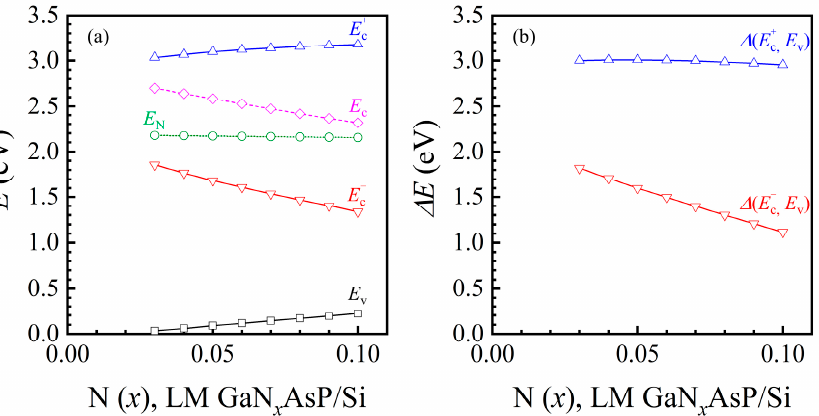
Figure 4. ( a ) Calculated E + c and E − c band edges of Si-lattice-matched GaN x AsP y (LM GaN x AsP/Si), as a function of N mole fraction. The reference energy level is the valence band edge of GaP. The valence band edge ( E v ), the conduction band edge ( E c ), and the nitrogen level ( E N ) of the original GaAsP y ; ( b ) Calculated Si-lattice-matched GaN x AsP energy gap ( ∆ E ) between E + c and valence band ( E v ), ∆ E ( E + c , E v ), and between E − c and E v , ∆ E ( E − c , E v ), as a function of N mole